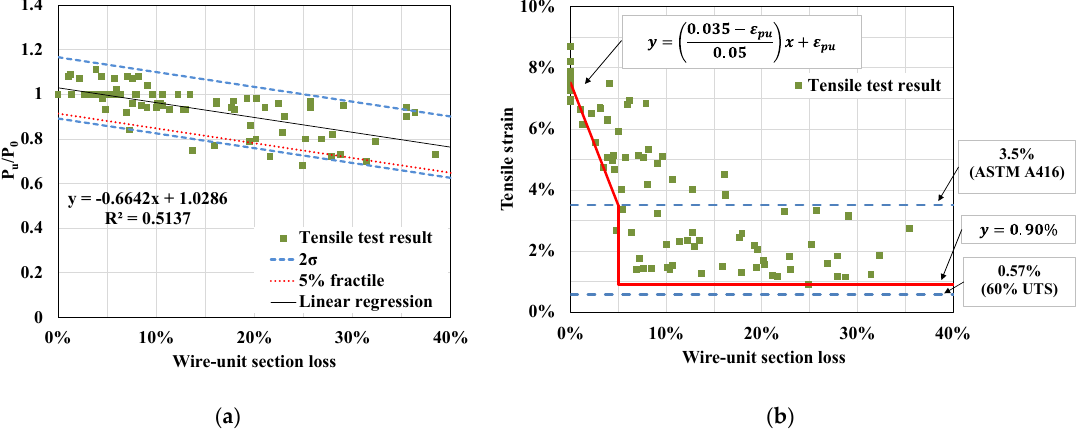
Figure 7. Tensile test results of corroded strands, ( a ) relationship between the ultimate load and the wire-unit section loss, ( b ) relationship between the ultimate tensile strain and the wire-unit section loss.